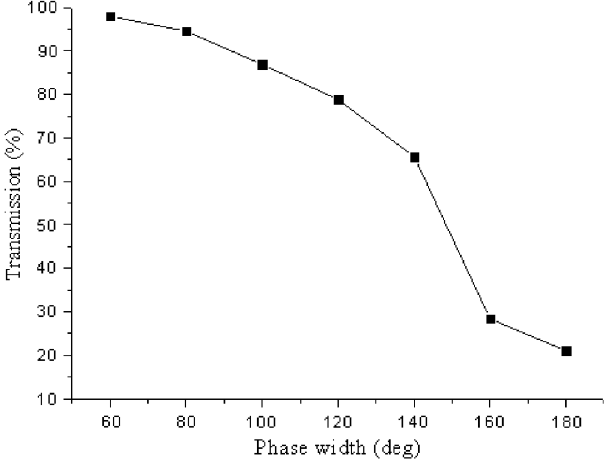
FIG. 18. Transmission as a function of intervane voltage.